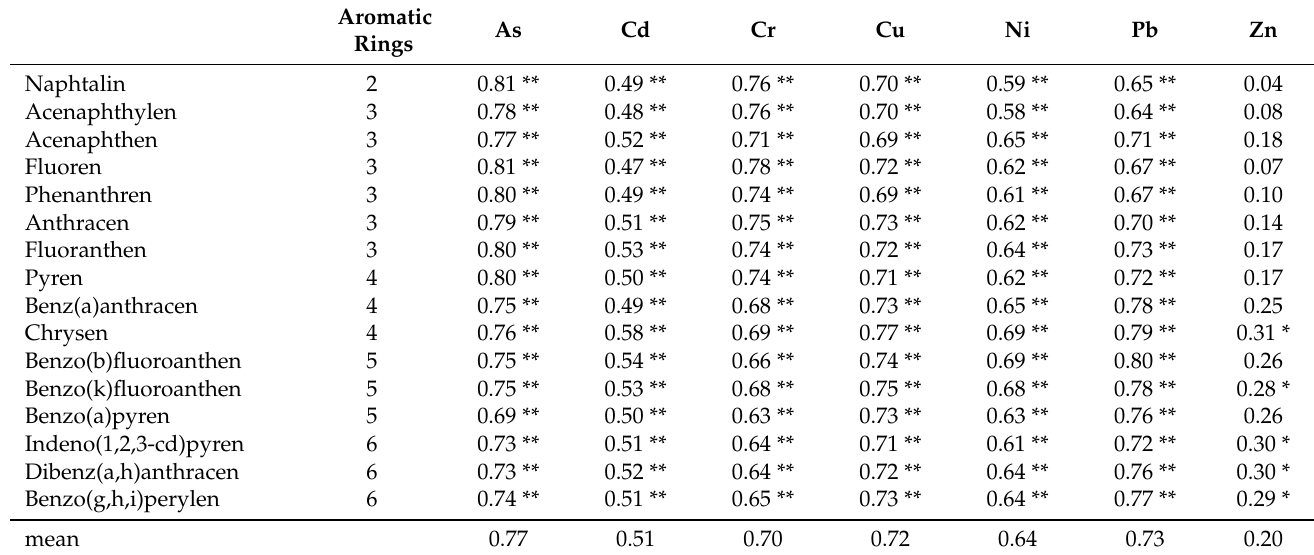
Table 3. Correlation coefficients between PAH 16 indicators and inorganic pollutants in the humus layer; significance: * p < 0.05, ** p < 0.01.